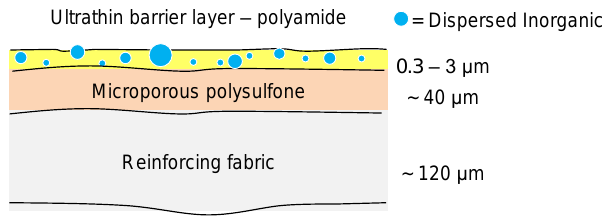
Figure 10. Schematic of a thin film nanocomposite membrane.